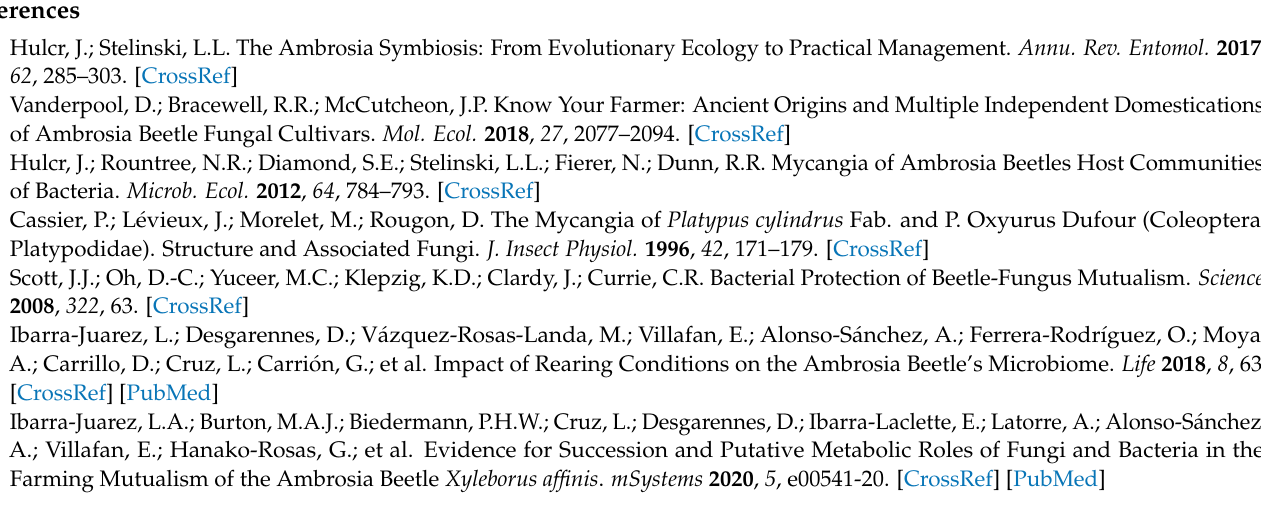
Table S1: DAtest results of the statistical test comparisons: (a) sequences collapsed at the genus level, (b) ASVs; Table S2: Bacteria 16S rRNA gene sequences and samples after quality filtering and rarefaction of input data; Table S3: Alpha diversity indices for mycangia of female and male adult beetles; Table S4: Alpha diversity indices for mycangia of beetles from different cork oaks; Table S5: Statistical results of the differential abundant analysis of the bacterial genera in female and male mycangia of P. cylindrus for Welch’s t -test ( p < 0.05); Table S6: Statistical results of the differential abundant analysis of the bacterial sequences (ASVs) in female and male mycangia of P. cylindrus for Welch’s t -test ( p <